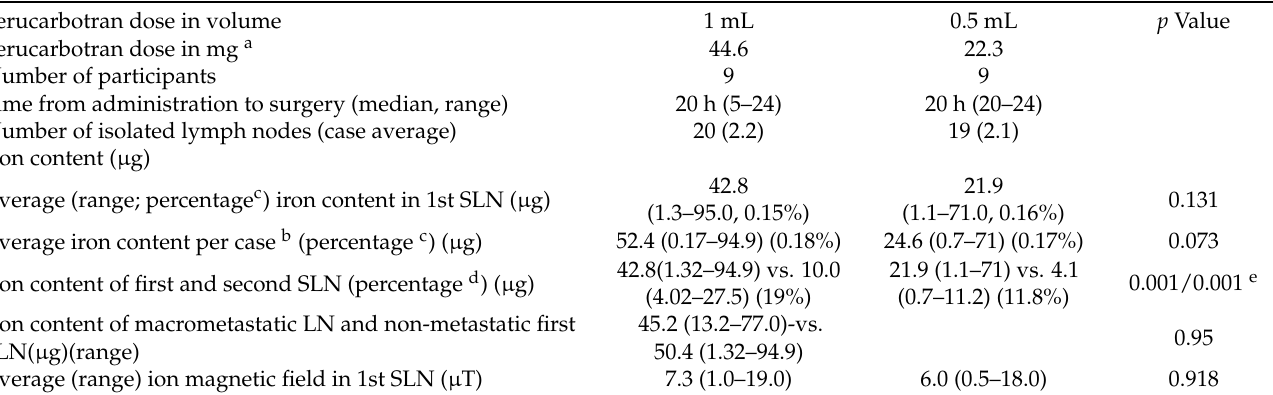
Table 2. Sentinel lymph node (SLN) findings.